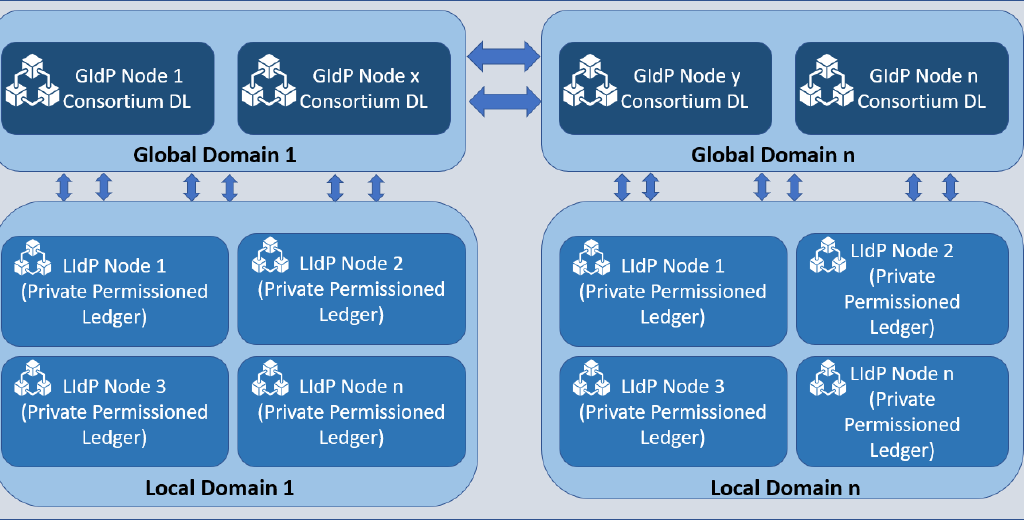
Figure 4. IdP nodes represented as groups.